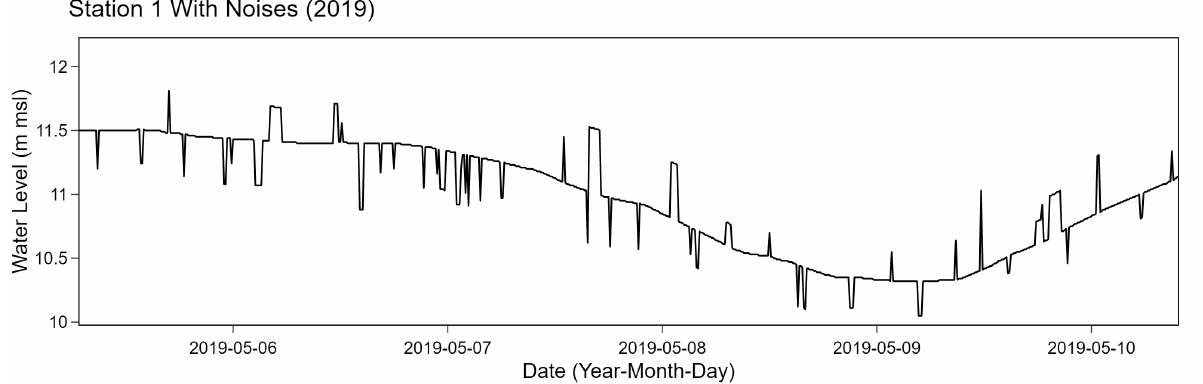
Figure 7. Example of station 1 with